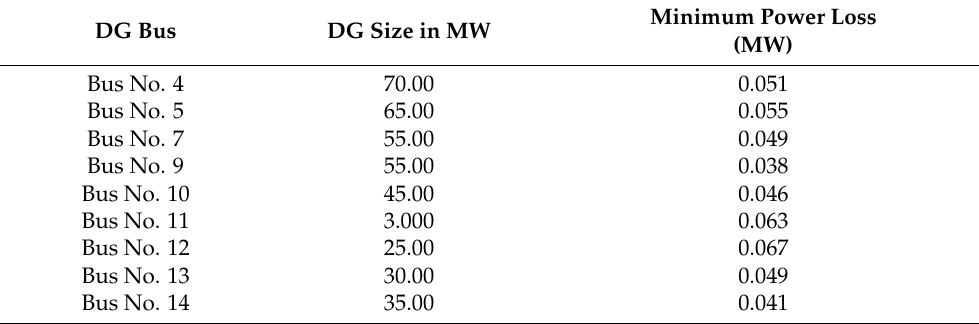
Table 4. DG capacity at all load buses with power loss minimization criteria for the 14-bus system of